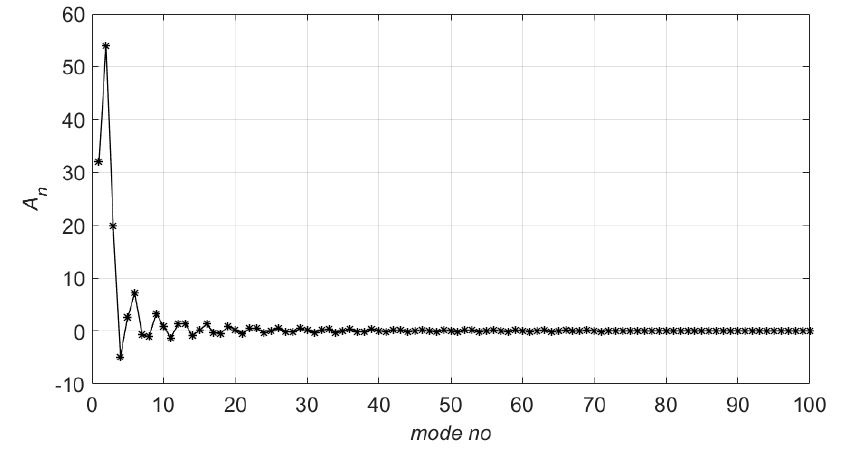
Figure 2. The expansion coe ffi cients A n , n ≥ 1, for a = 0.6, v = 300 and t = 0.01